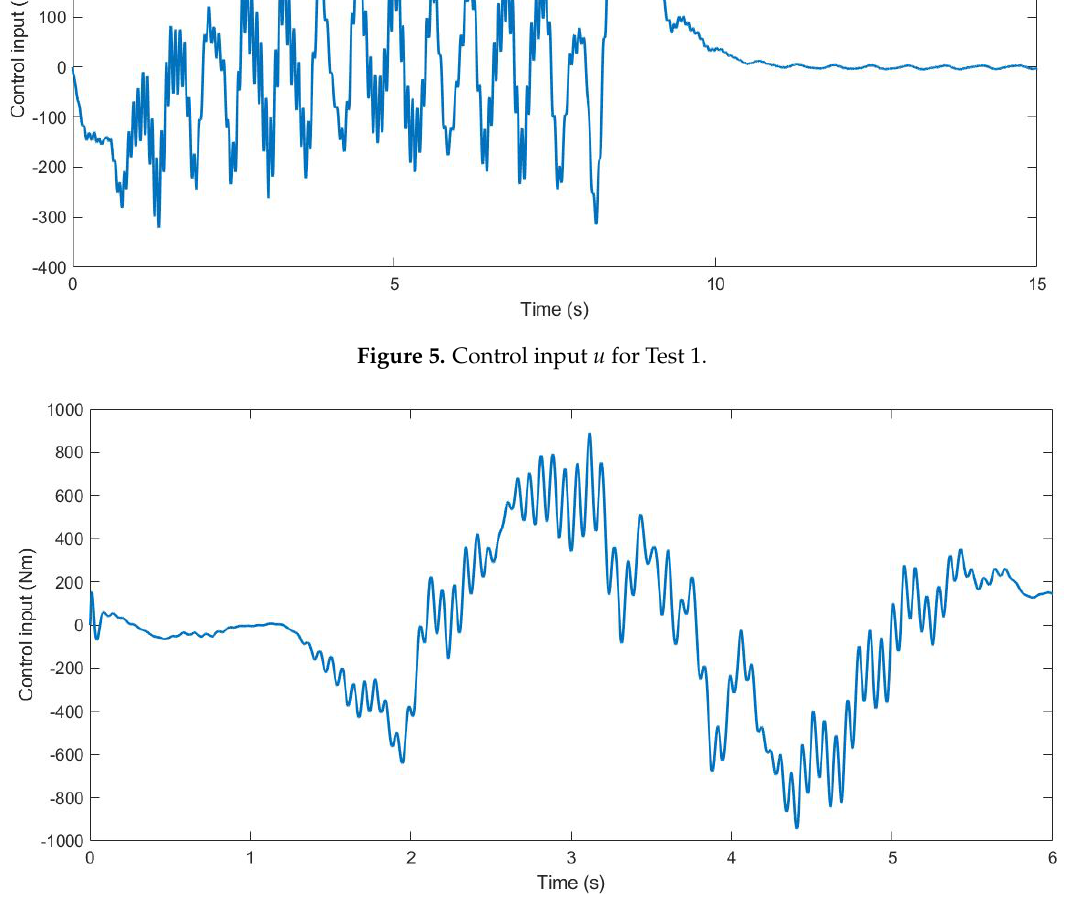
Figure 6. Control input u for Test 2.